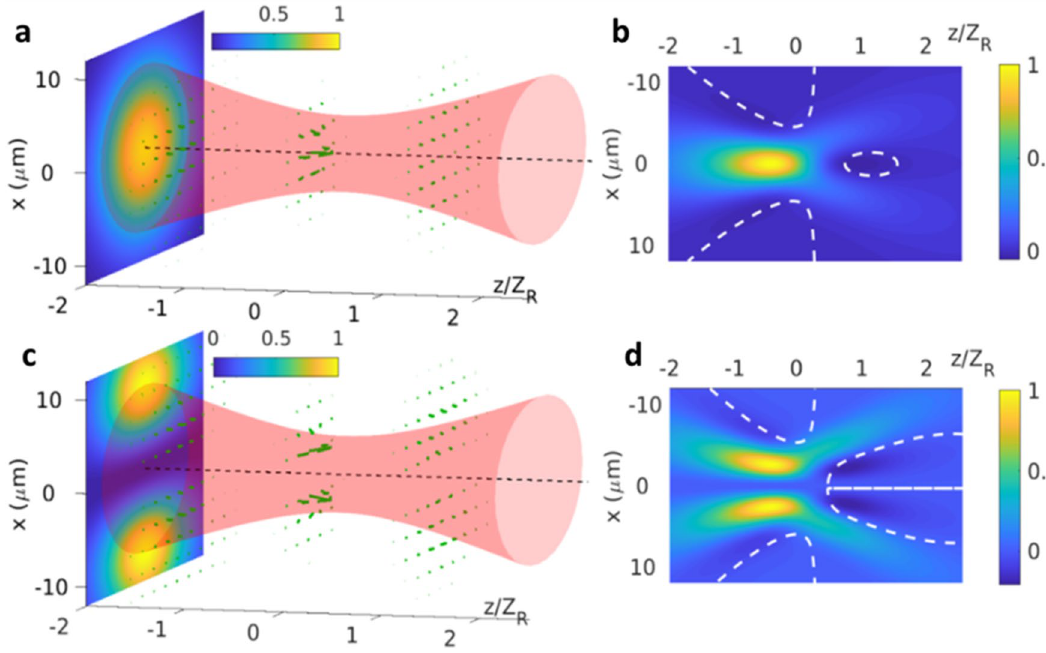
Figure 8. ( a ) Force exerted on a spherical (Rayleigh) particle of 30 nm in diameter when it is illuminated by a tightly focused fundamental Gaussian beam of 4 μm in radius at the focal point. m = 1.097 is used. ( b ) The normalized z -component of the radiation force on y = 0 plane. The zone of vanishing z -component of the radiation force is along the dashed line in white. ( c ) The exerted force on a spherical (Rayleigh) particle of 30 nm in diameter for TE 10 (TM 10 ) mode of the same beam radius. ( d ) The normalized z -component of the radiation force on x = 0